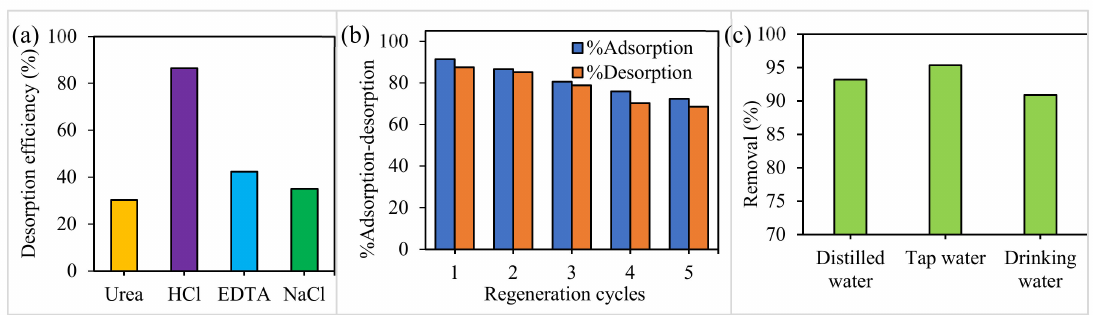
Figure 7. ( a ) Di ff erent de-sorbents to recover Cd 2 + from PVA-CDs, ( b ) reusability study of PVA-CDs for five cycles using HCl and ( c ) real water sample test of